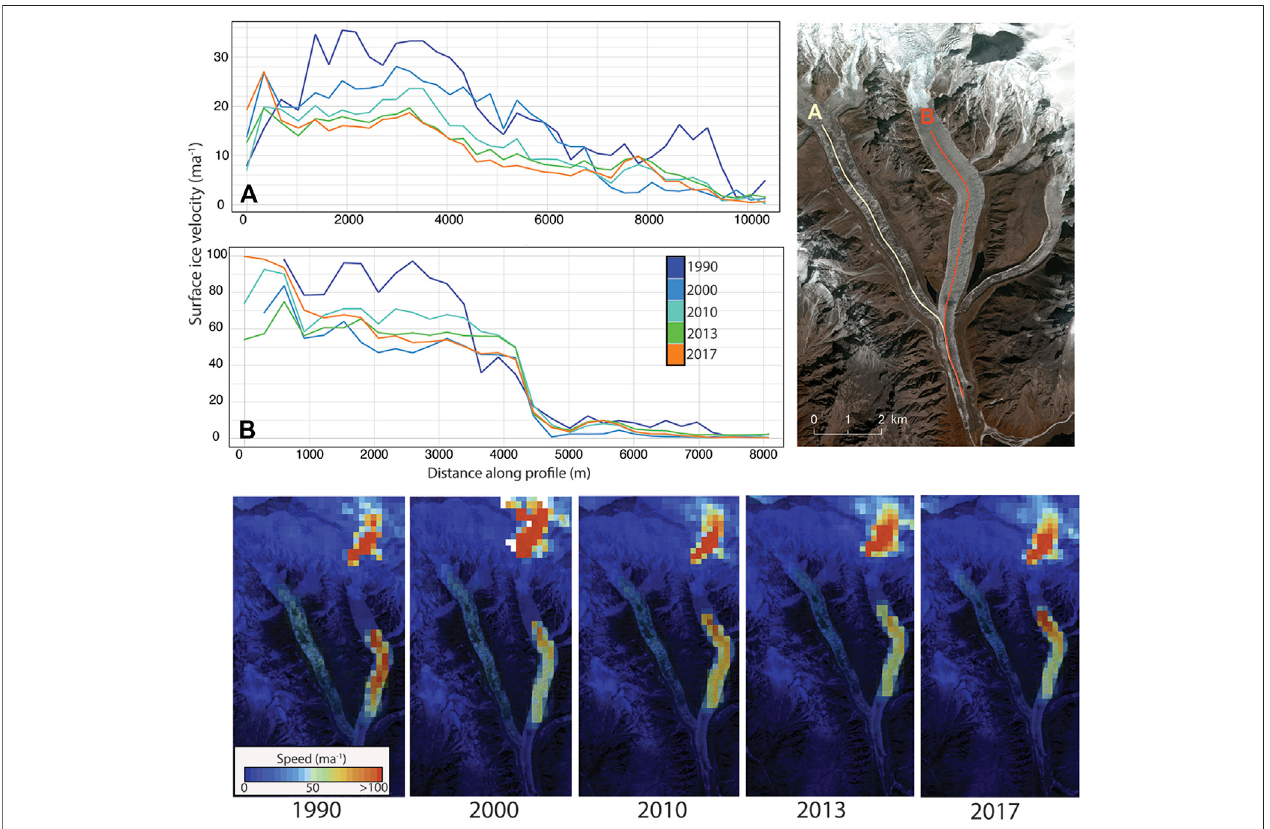
FIGURE8| Ice velocity changesofthePonkarGlacierbetween1990and2017.Panel (A) and (B) representvelocity pro fi lesalongthe fl owline ofthetwobranches of Ponkar Glacier (light yellow and red solid lines, respectively, overlayed on The RapidEye imagery from 2019. The bottom panels show the ice velocity mosaics color coded on a linear scale from blue (low velocity) to red (velocity > 100 ma − 1